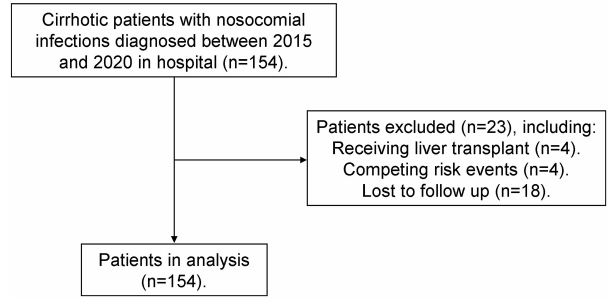
Figure 1. Flowchart for analysis of patients selected in this